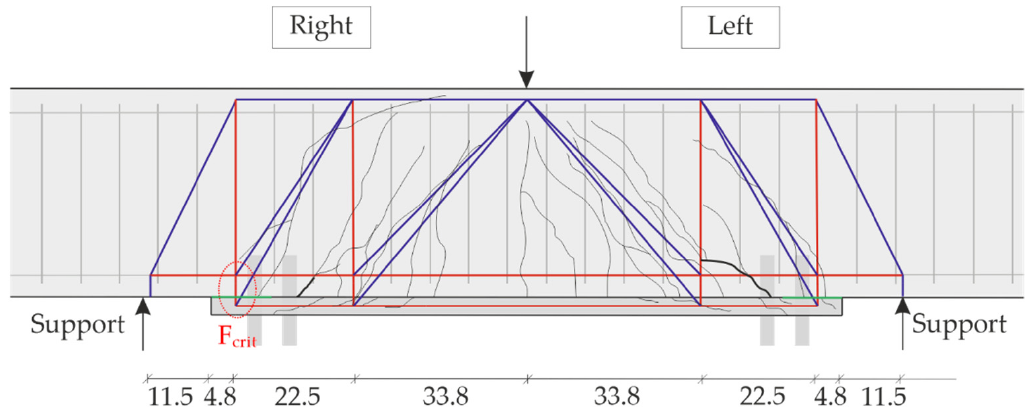
Figure 25. Final crack state and strut-and-tie-model for specimen 2. (Graphic: CARBOCON GMBH).